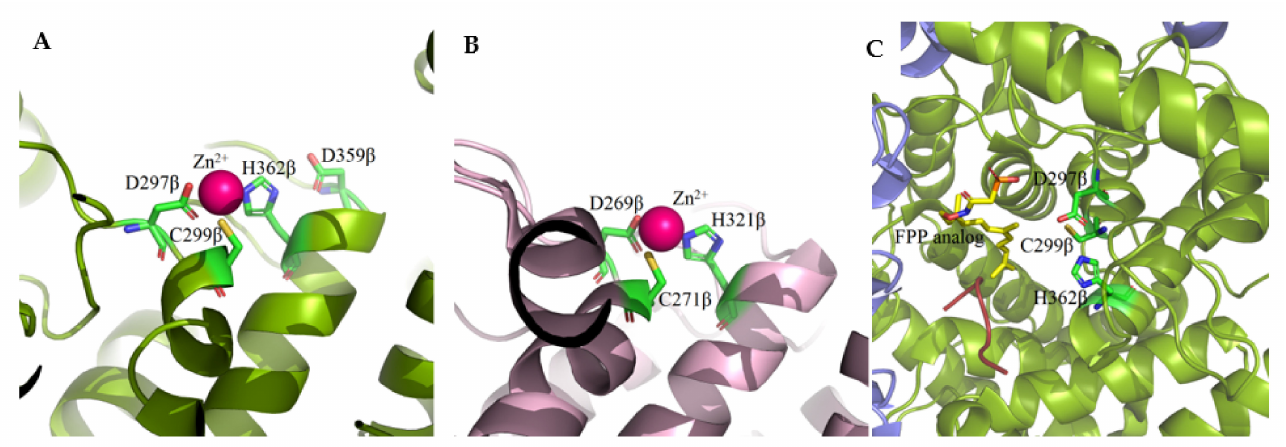
Figure 3. A single Zn 2+ ion bound to the β subunit of FTase ( A ) (PDB: 1FT1) and GGTase-I ( B ) (PBD: 1N4P) is coordinated by three conserved amino acid residues, Asp, Cys, and His. Zinc- depleted FTase complexed with K-RAS4B peptide substrate and FPP analog ( C ) (PDB: 1D8E). (Created in the PyMOL Molecular Graphics System, Version 2.5.2 Schrödinger,